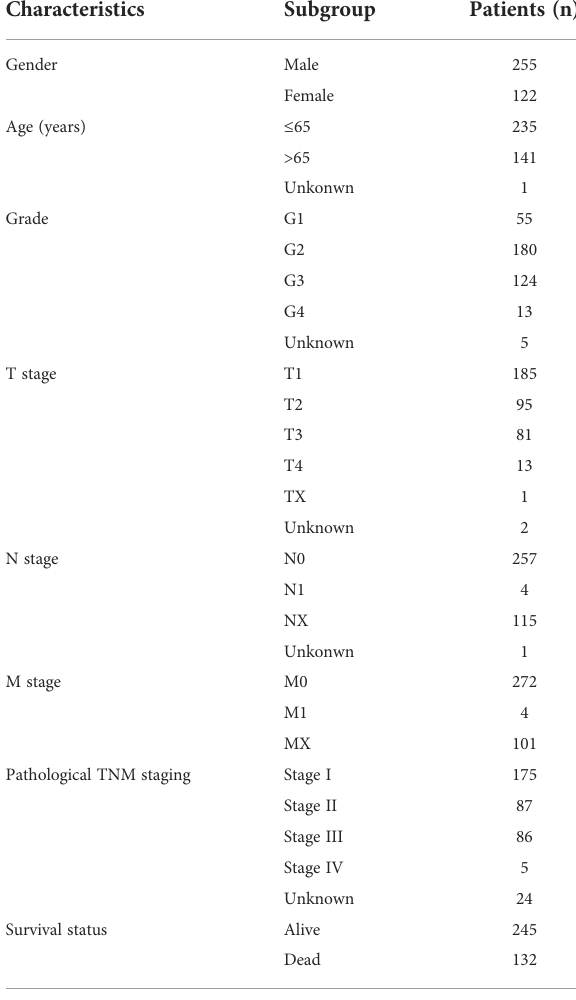
TABLE 1 Clinical pro fi les of HCC patients from TCGA dataset.